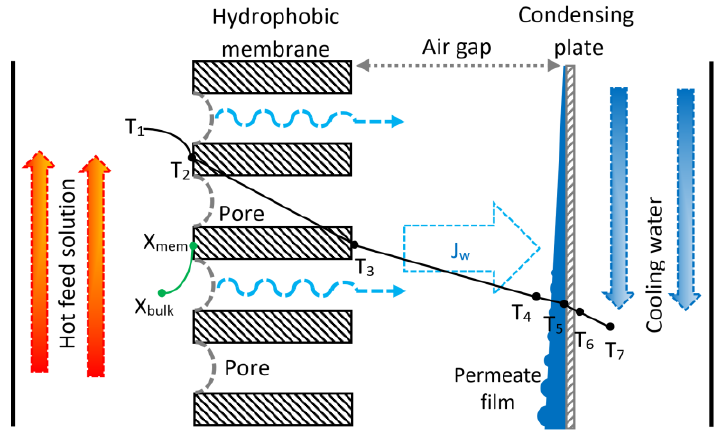
Figure 5. Conceptual diagram of the AGMD process.